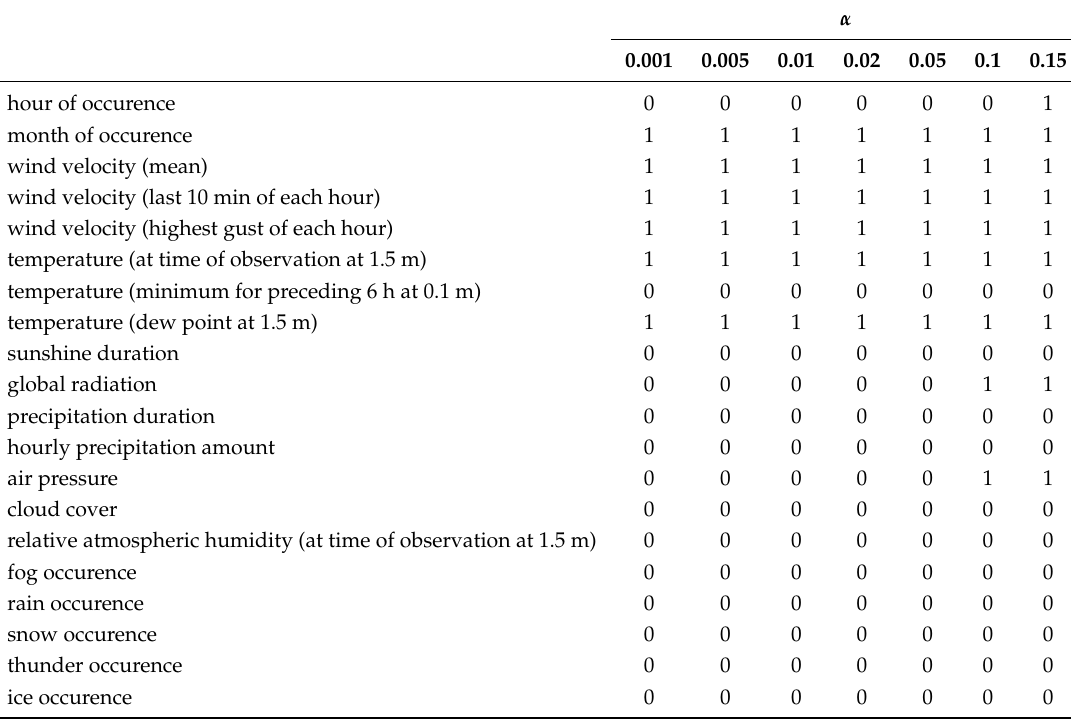
Table 3. Two-sample Kolmogorov-Smirnov test between limited and unlimited data for various variables and alpha values. Acceptance of the null hypothesis are marked with 0, a rejection (i.e., the data comes from different distributions) it with